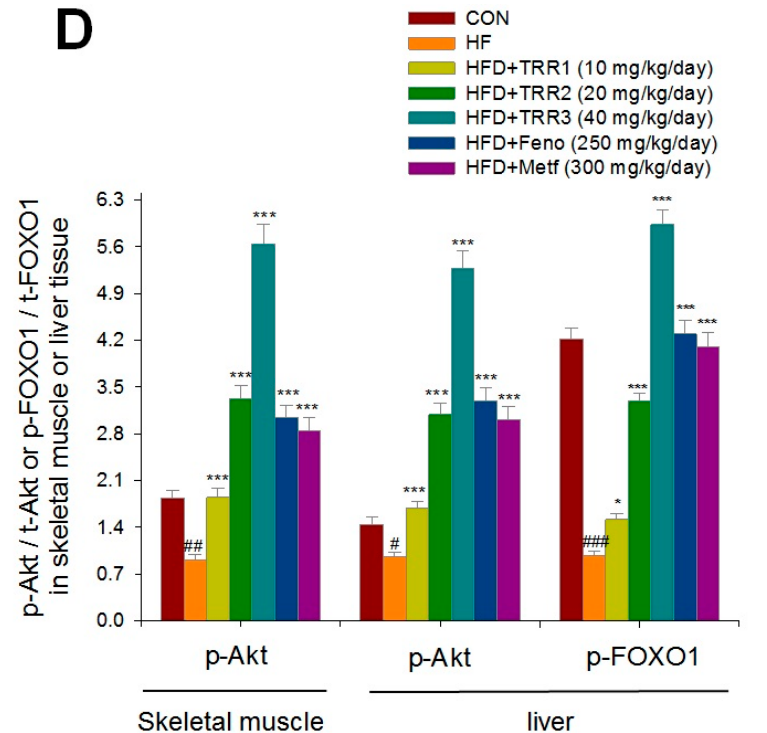
Figure 6. Membrane GLUT4 protein contents in skeletal muscle, or expression levels of phospho-Akt